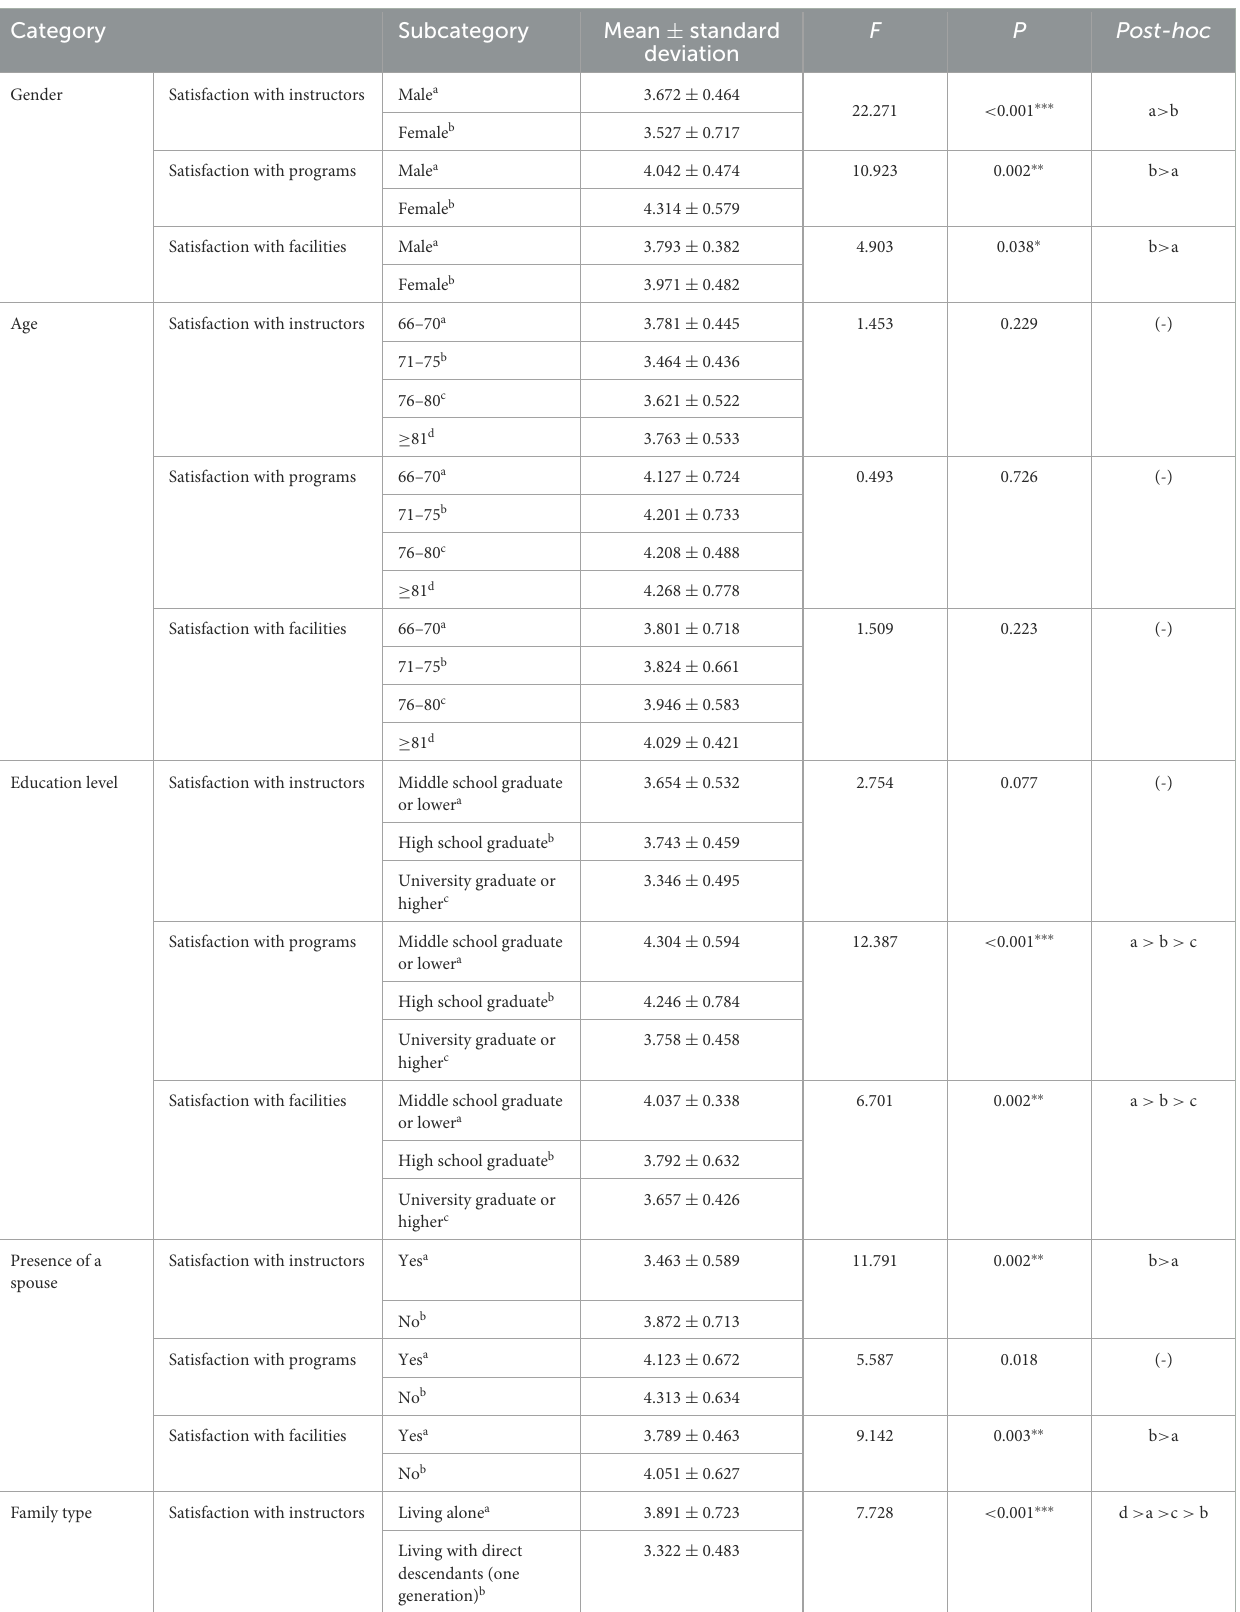
TABLE 4 Results of the one-way analysis of variance (ANOVA) for user satisfaction with the demographic characteristics of the elderly.